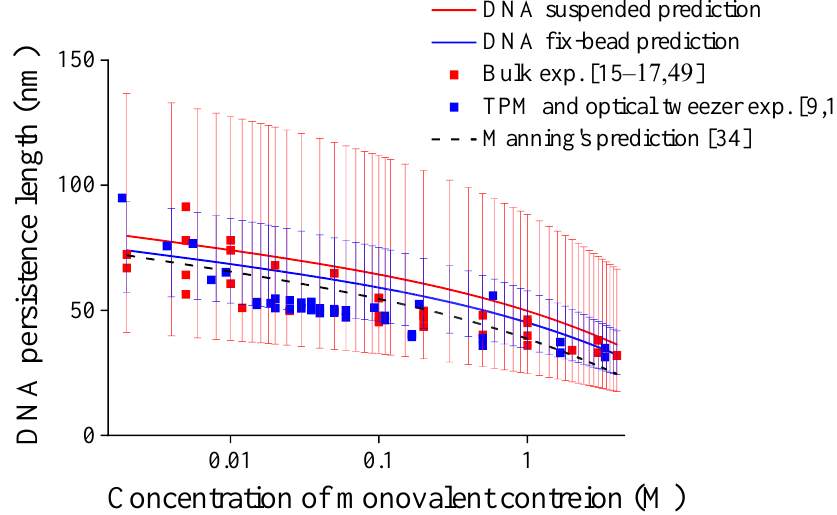
Figure 2. Persistence lengths of DNA under different end-constraints versus monovalent ionic concentrations, error bars are caused by standard deviations of averaged effective length factors with µ = 1.021 ± 0.250 for DNA suspended in solution while µ = 0.718 ± 0.075 for fix-bead one.